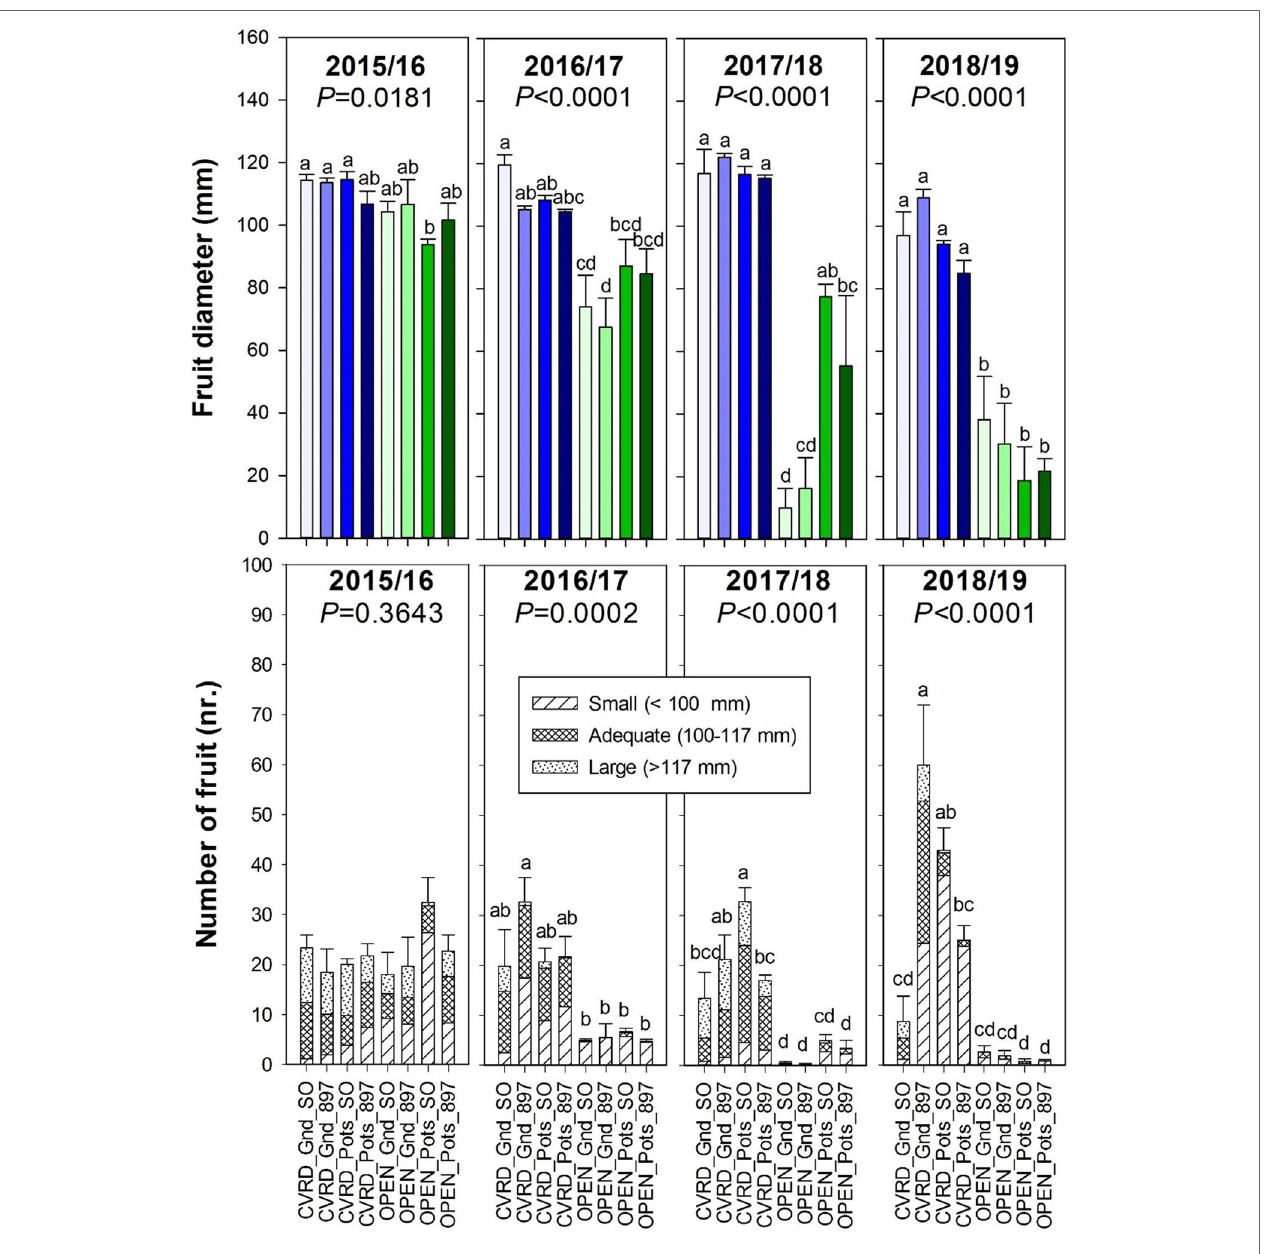
FIGURE 6 | Fruit diameter (top) and number of fruit (bottom) of “ Ray Ruby ” grapefruit trees cultivated under two production systems (screenhouse, CVRD and open-air, OPEN), two planting systems (in-ground, GND and potted, POTS), and two rootstocks ( “ Sour Orange, ” SO, and “ US-897 ” ), with four replications arranged in a split-split-plot experimental design. Mean ± standard error of four replications. Means with the same letter are not signi fi cantly different from each other at 5% probability ( P ≤ 0.05) using Tukey mean comparison